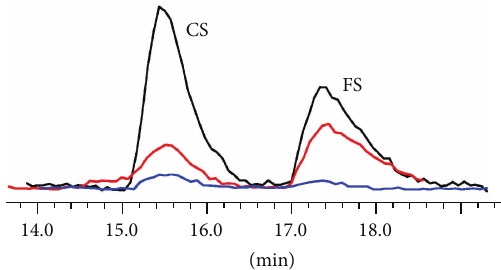
Figure 6: Projection of the phytosterol content in the sea buckthorn extracts (SEC-NMR measurement in 100% CDCl 3 ), leaves (black), seed oil (red), and seed coat (blue). CS: conjugated phytosterols and FS: free phytosterols.